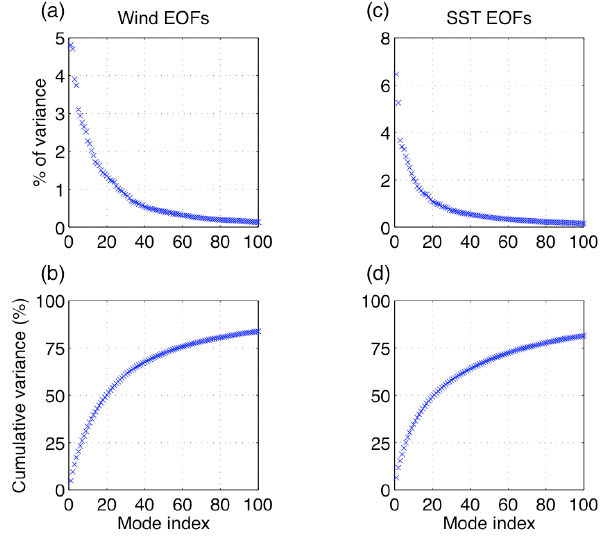
Figure 3. Variances accounted for by the 100 leading EOF modes of (a,b) SLW and (c,d) 2 Fig. 3. Variances accounted for by the 100 leading EOF modes SST; individual and cumulative variances appear in panels (a,c) and (b,d), respectively. 3 of (a, b) SLW and (c, d) SST; individual and cumulative variances appear in panels (a, c) and (b, d) , respectively.